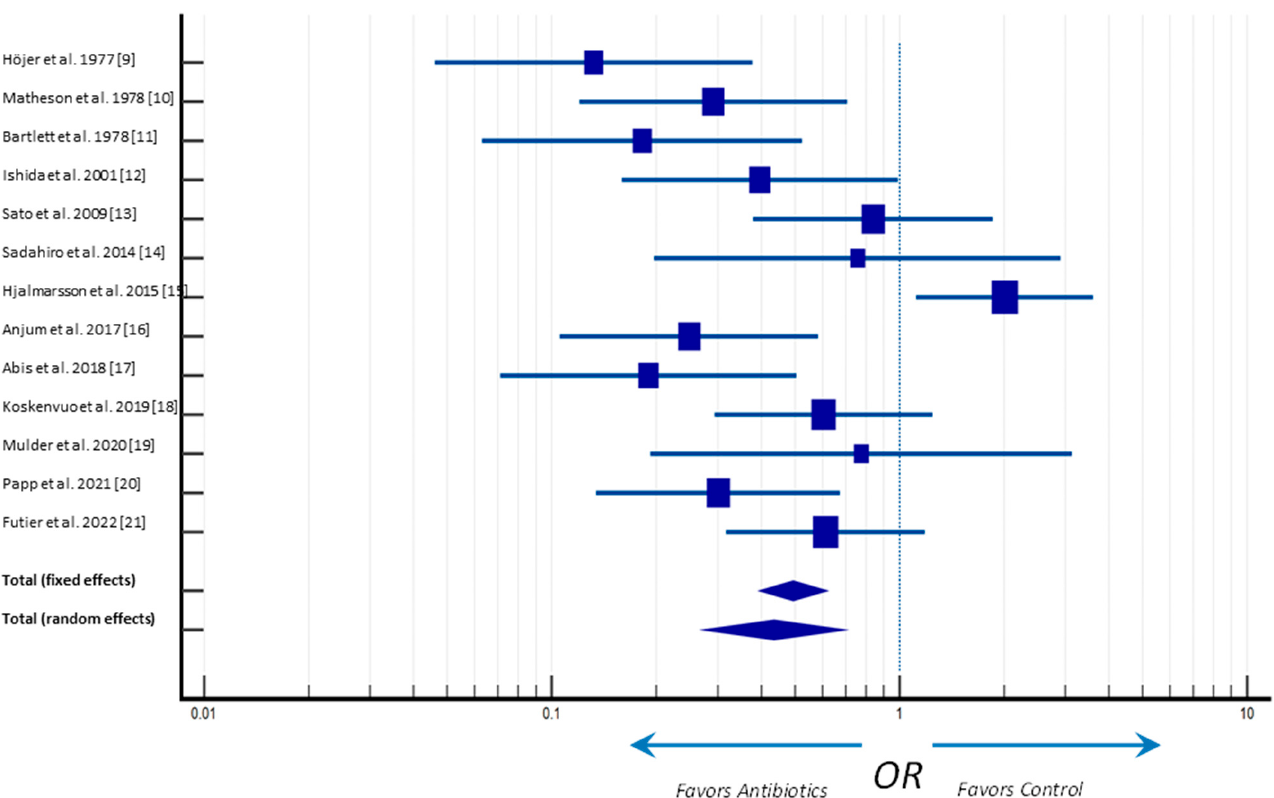
Figure 5. Forster plot of surgical site infections. Odds ratio (OR) and 95% confidence intervals (CI).